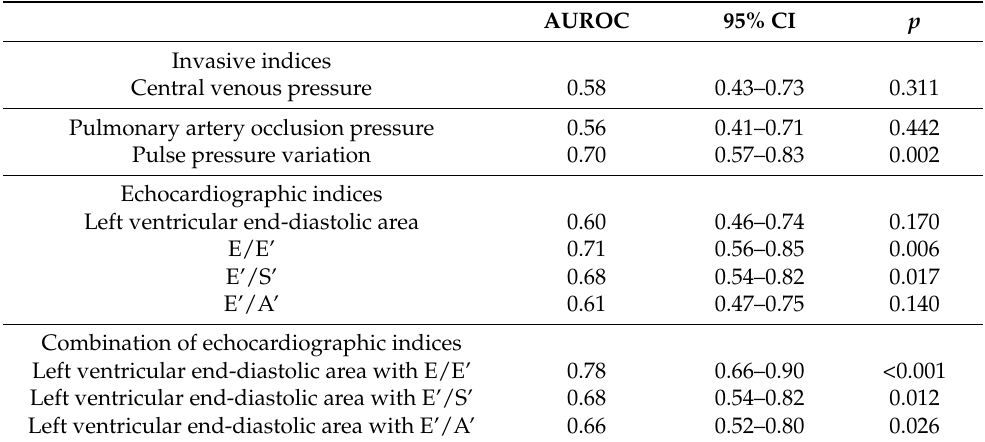
Table 4. Receiver operating characteristic curves of indices of predicting fluid responsiveness.